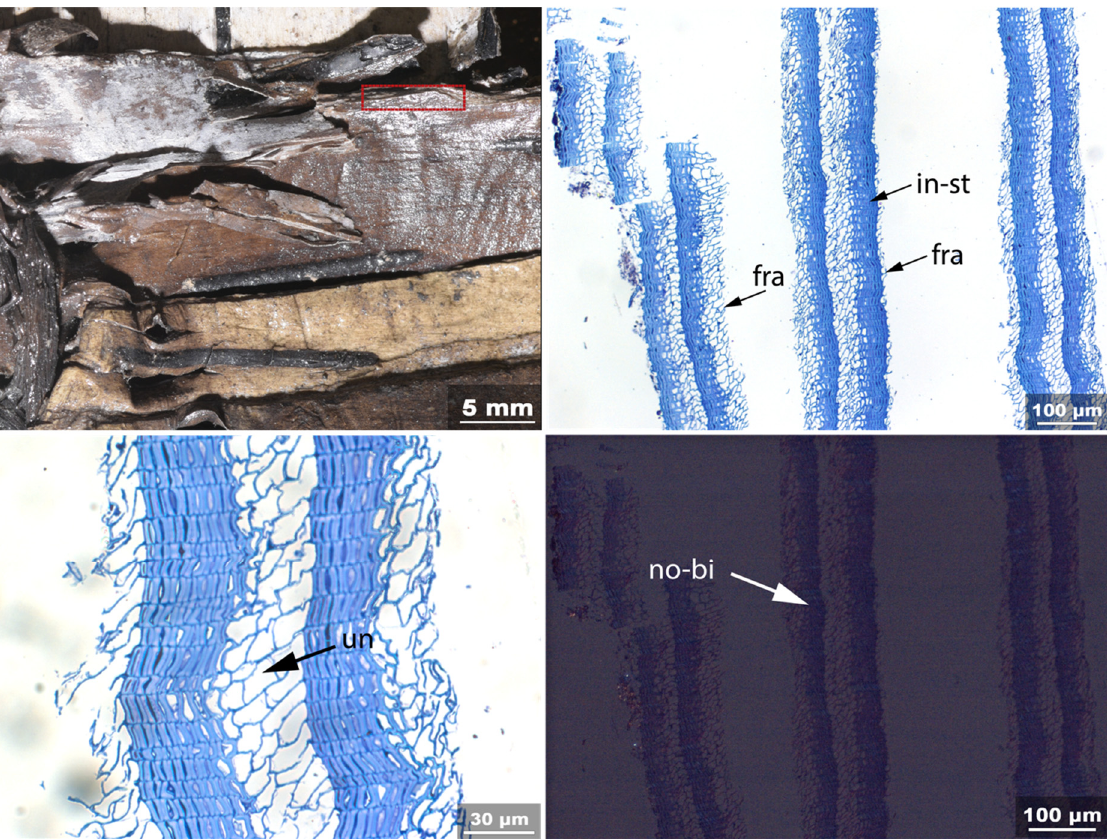
Figure 18. Sample 2. Top left: location of sample. Right: LM of thin sections. Tangential delamination is visible due to fracture (fra) of radial thin-walled cells. Increased toluidine staining of thick-walled cells is also appreciable (in-st). Bottom left: thin-walled cells in normal phellem are overall unfolded (un). Bottom right: birefringence is absent in both thick- and thin-walled cells.